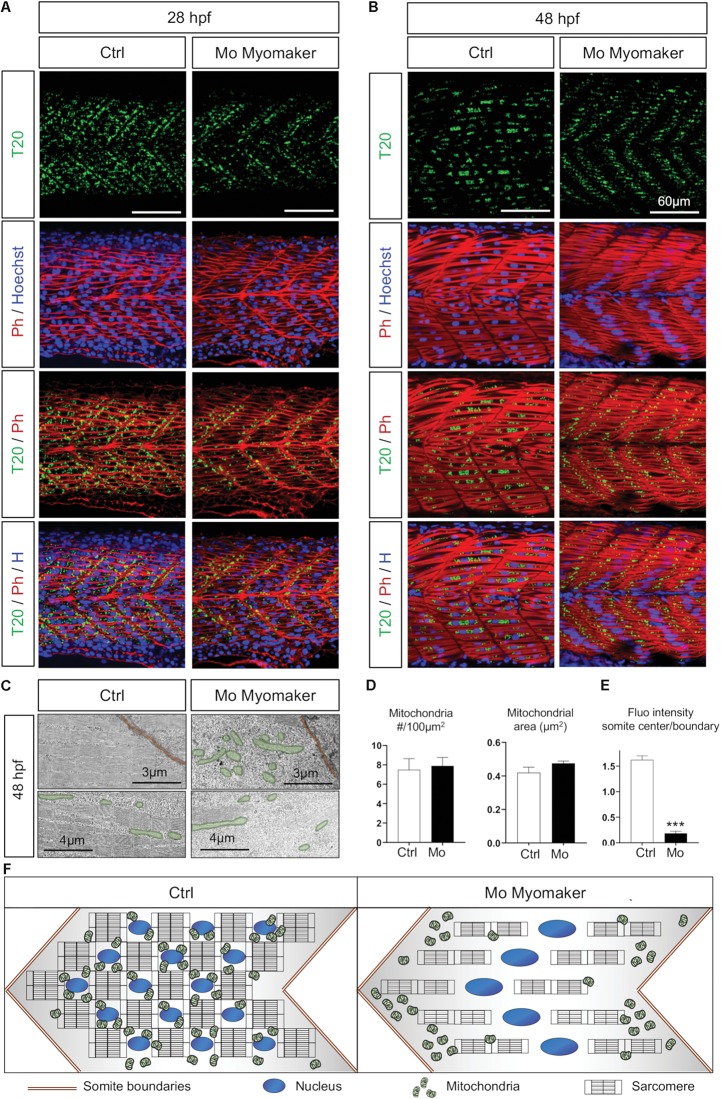
Mitochondrial network maturation is conditional to myoblast fusion. (A,B) Confocal imaging of mitochondrial network (Tomm20, T20; green) counterstained with Phalloidin (Ph; red) and Hoescht (H; blue) at 28 hpf (A) and 48 hpf (B); control (Ctrl, mock injection) or Myomaker-targeting Morpholinos (Mo Myomaker). (C) Electron micrographs of longitudinal sections at 48 hpf in control and Myomaker depleted embryos. Top images are close to boundaries, bottom images are at the somite center. (D) Quantification of mitochondrial number and area at 48 hpf from longitudinal electron micrographs (n = 6 micrographs for Ctrl, n = 7 micrographs for Mo). (E) Quantification of Tomm20-zsGreen fluorescence ratio between somite center and boundary region 48 hpf (n = 4 fish per group, 3 images analyzed per fish). (F) Cartoon representing somite structure and mitochondrial network at 48 hpf in control and Myomaker depletion. Bars are mean ± SEM. ∗∗∗P < 0.001, unpaired T-test.